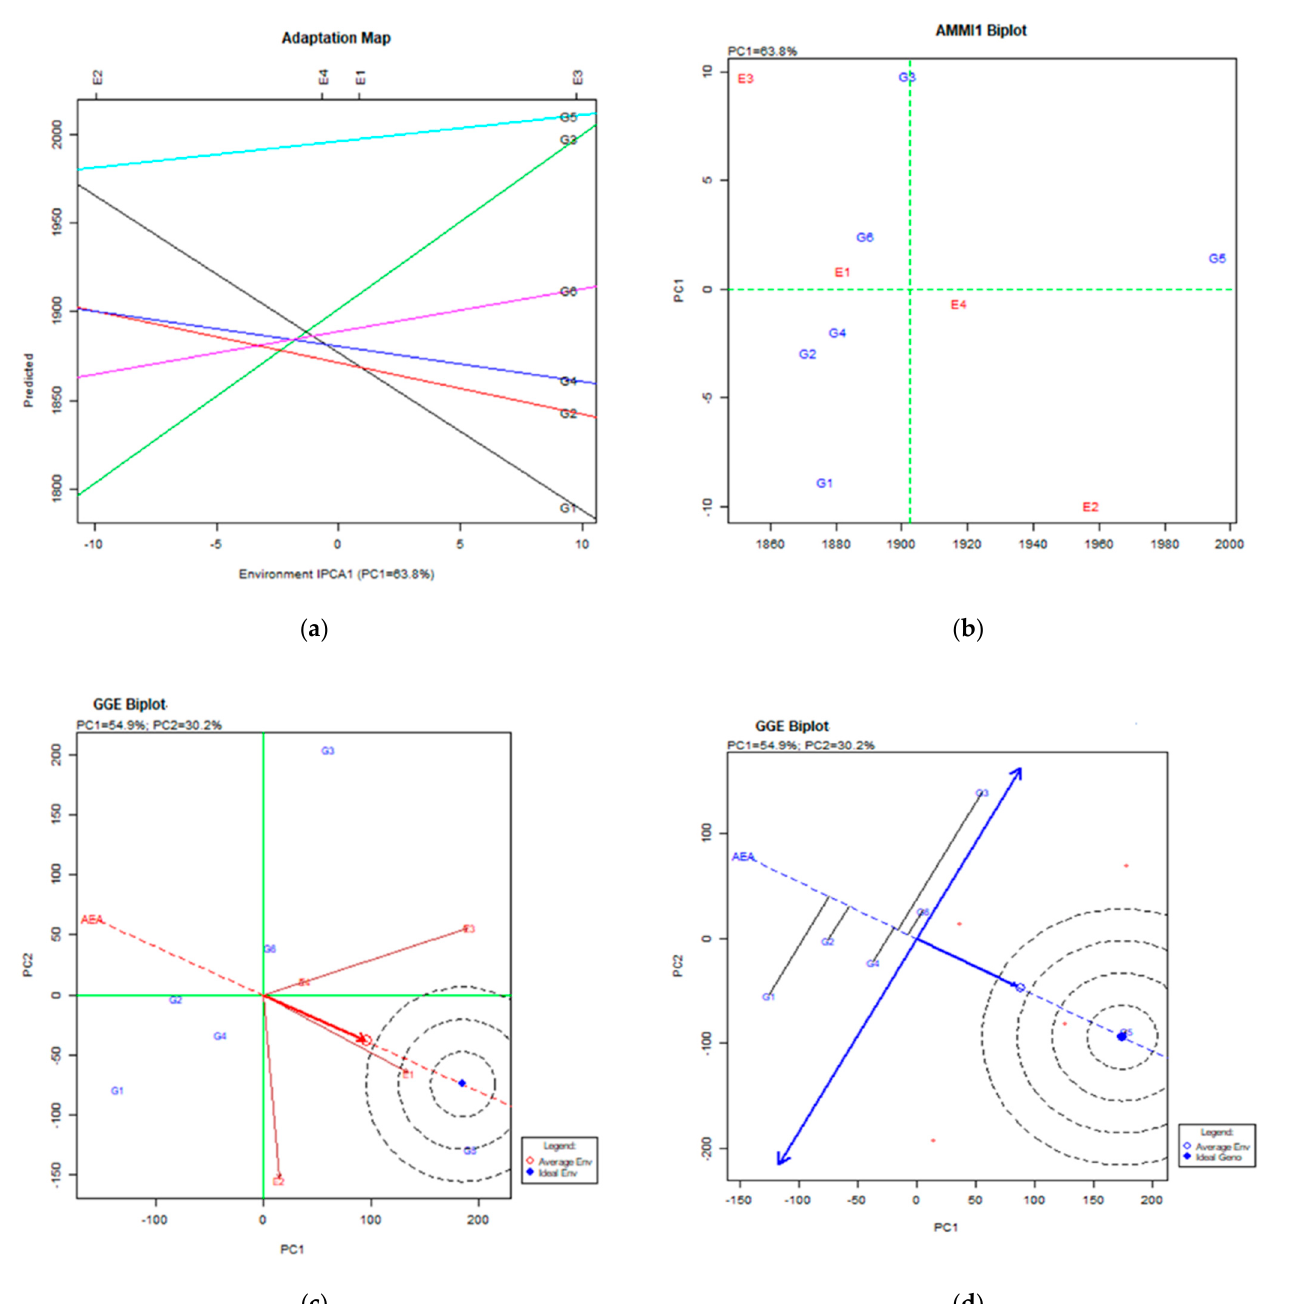
Figure 2. Stability analysis for fresh forage yield (kg ha − 1 ) based on ( a ) the adaptation map where the X-axis (PC1) visualizes the stability of varieties over environments and the Y-axis—the performance of varieties for the trait; ( b ) the AMMI1 biplot where the Y-axis is the one visualizing the trait performance and the X-axis (PC1) visualizes the stability of varieties over environments; ( c ) the GGE biplot for environments depicting the stability of the environments over years via the placement as near as possible to the ideal and average environment; ( d ) the GGE biplot for varieties depicting the stability of the varieties over environments where the productive varieties are those to the right on the AEA vector and the stable ones are those which are as close to the AEA axis as possible.